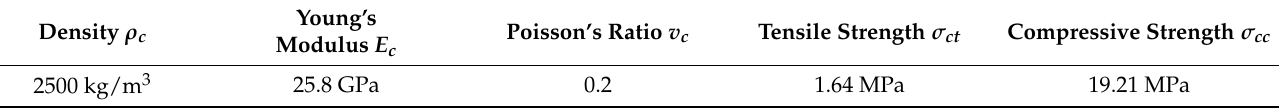
Table 2. Properties of precast concrete cubes.